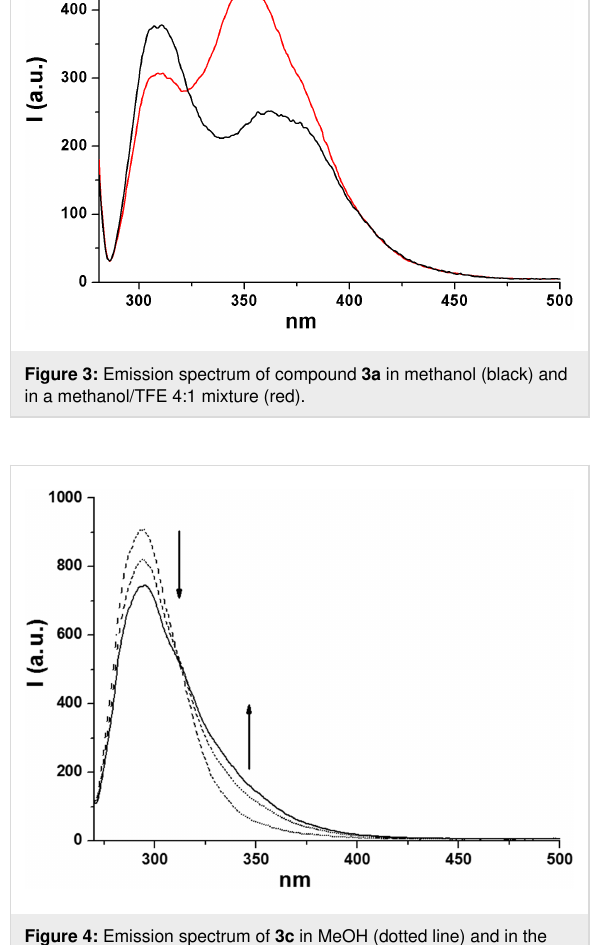
Figure 4: Emission spectrum of 3c in MeOH (dotted line) and in the presence of increasing amounts of TFE (up to 20% v/v, continuous